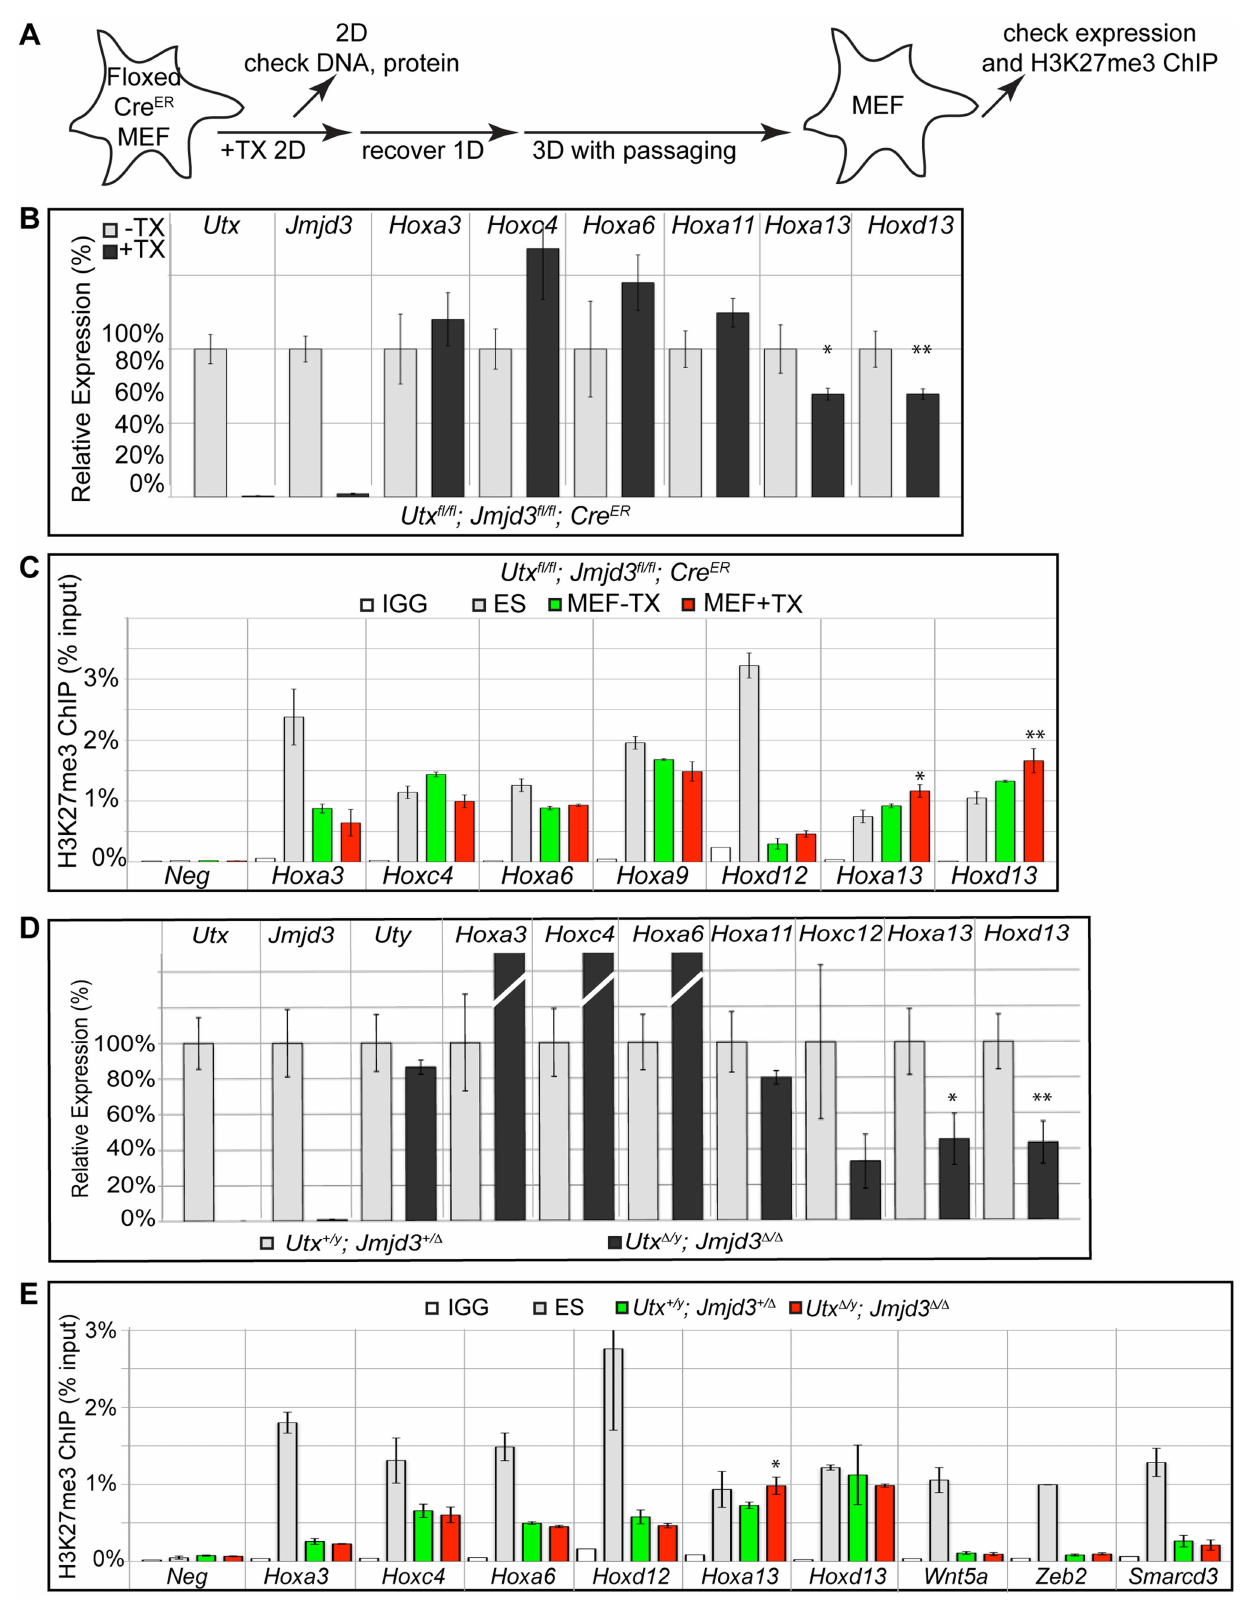
Figure 7. RT-PCR and H3K27me3 ChIP of UtxandJmjd3 mutant MEFs. (A) Schematic of MEF TX treatment. (B) Quantitative RT-PCR of indicated genes from Utx fl/fl ; Jmjd3 fl/fl ; Cre ER mouse embryonic fibroblasts (MEFs) left untreated ( 2 TX, light grey) or pre-treated with TX ( + TX, black). Significant reductions in Hox expression are indicated (T-test p-value *=0.05, **=0.02, N=3 samples per treatment). (C) H3K27me3 ChIP of